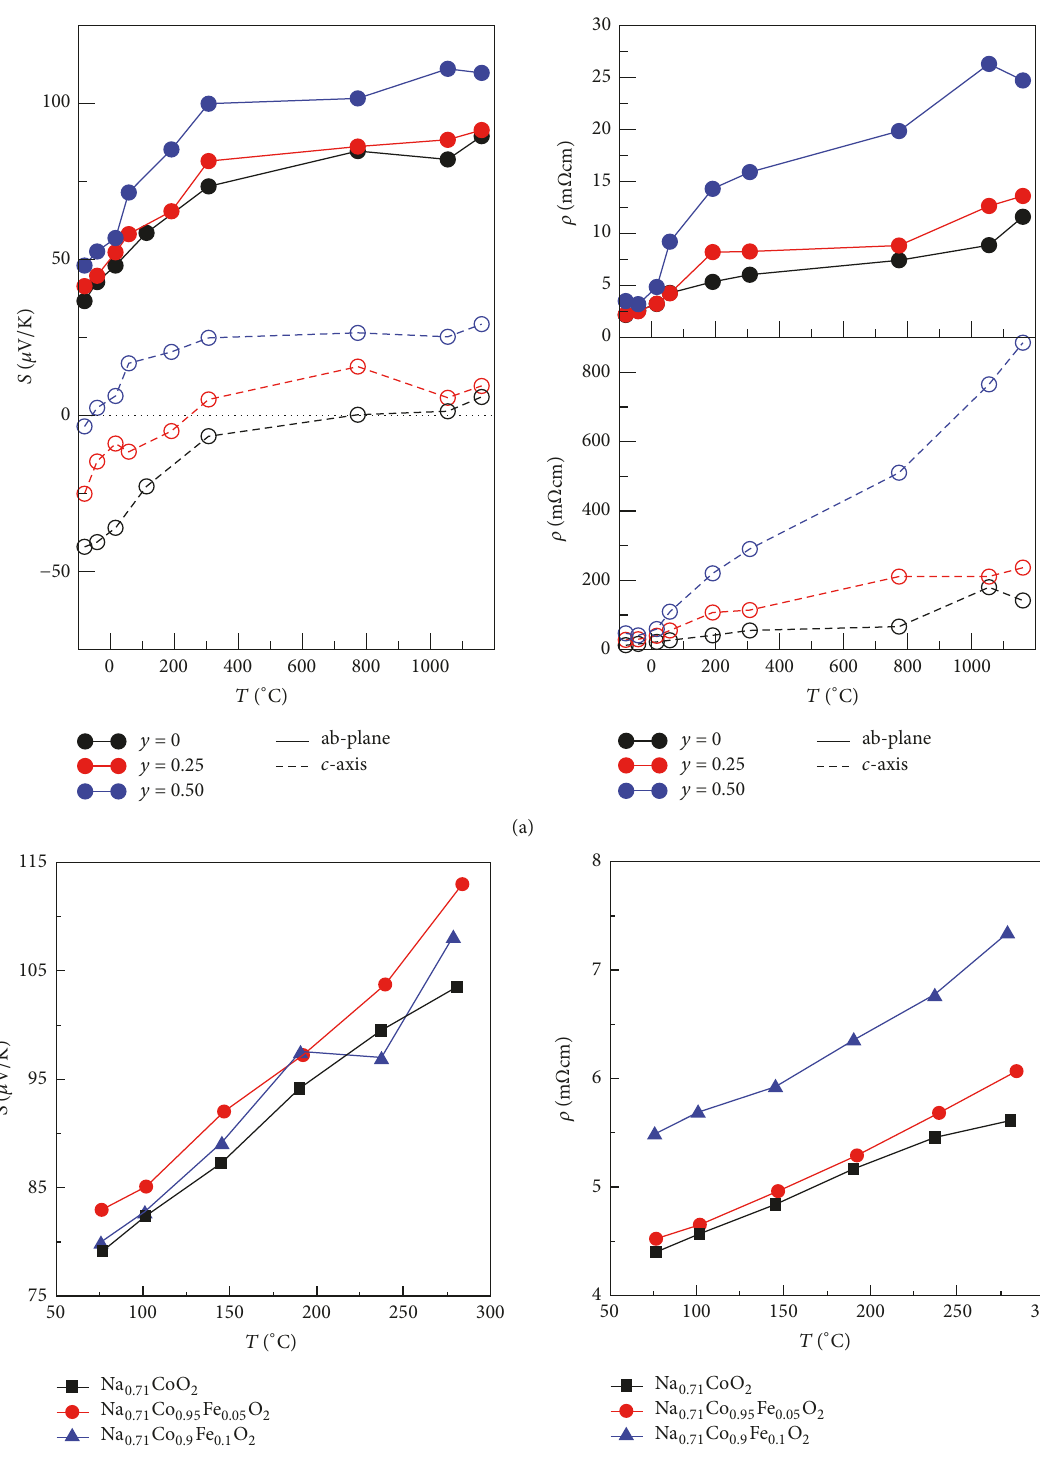
Figure 4: (Color online) Thermopower and resistivity for different Fe doping 𝑦 . (a) Theoretical data from DFT + DMFT for 𝑦 = 0, 0.25, 0.50 . Solid lines: in-plane and dashed lines: along 𝑐 -axis. (b) Experimental data for 𝑦 = 0, 0.05, 0.10